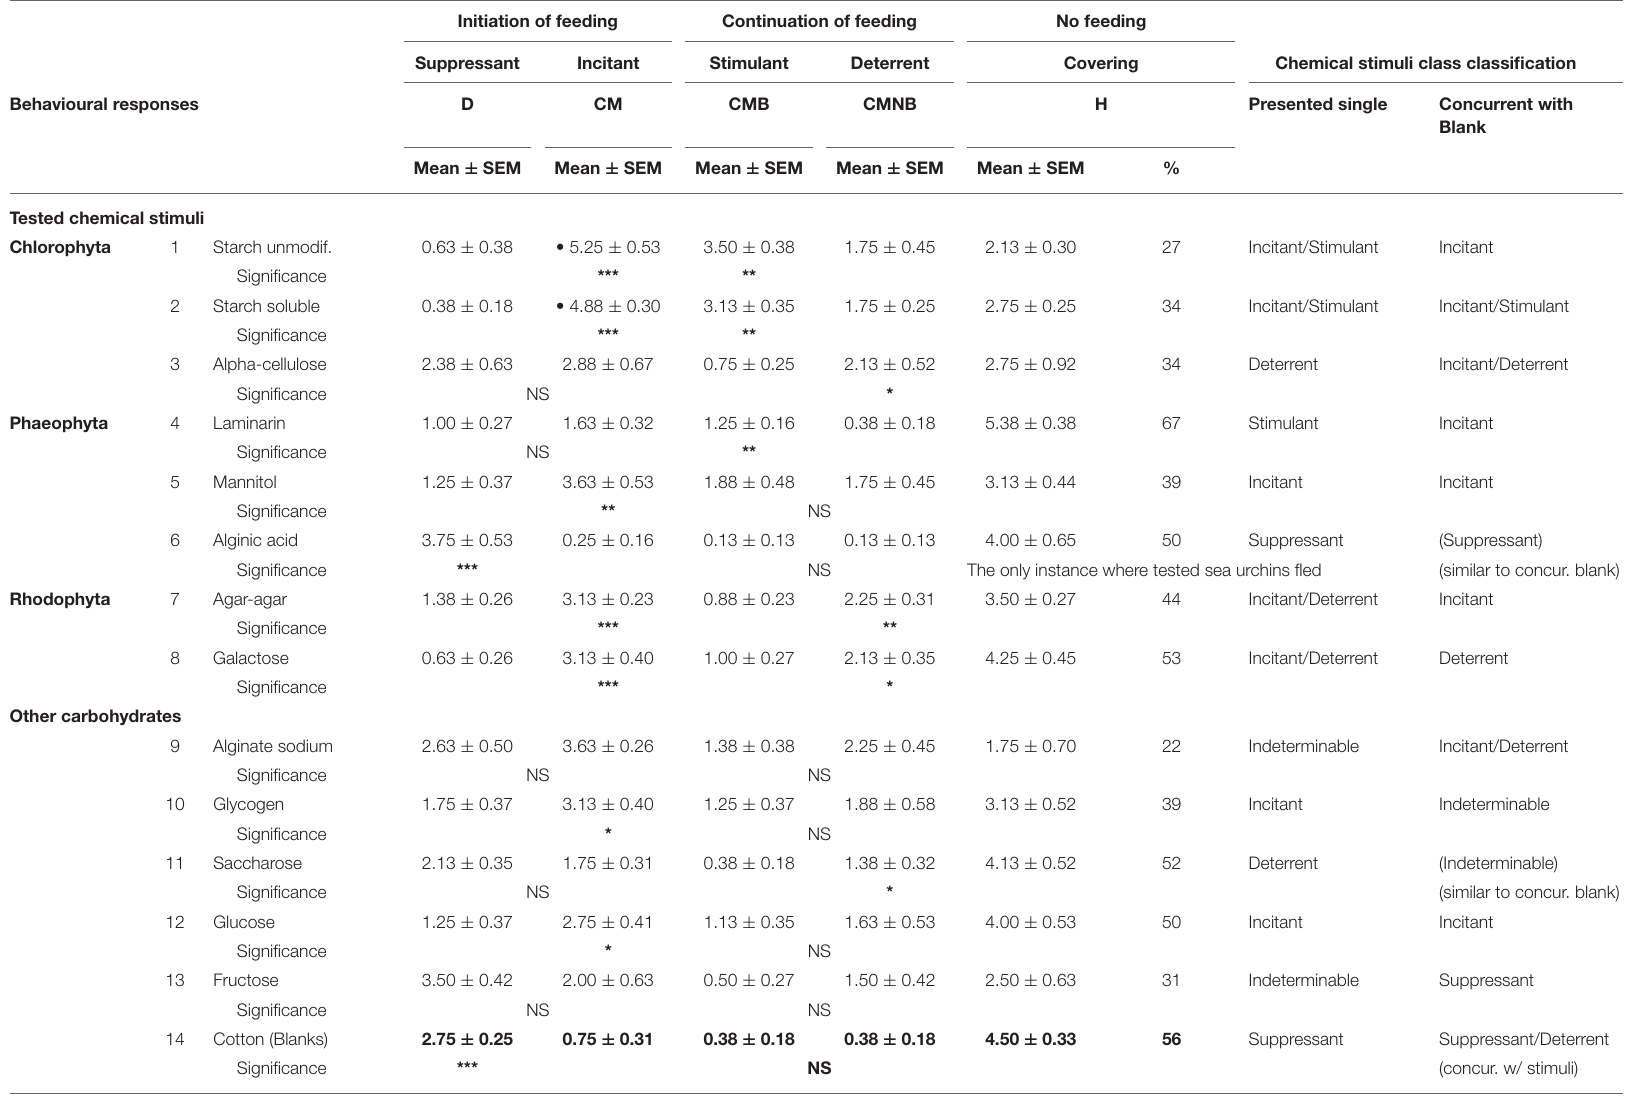
TABLE 6 | Sea urchin behavioural responses to 41 singly presented chemical stimuli as solutions at 1% concentration soaked in cleaning cloths or as tissues, and resultant classifications of the chemical